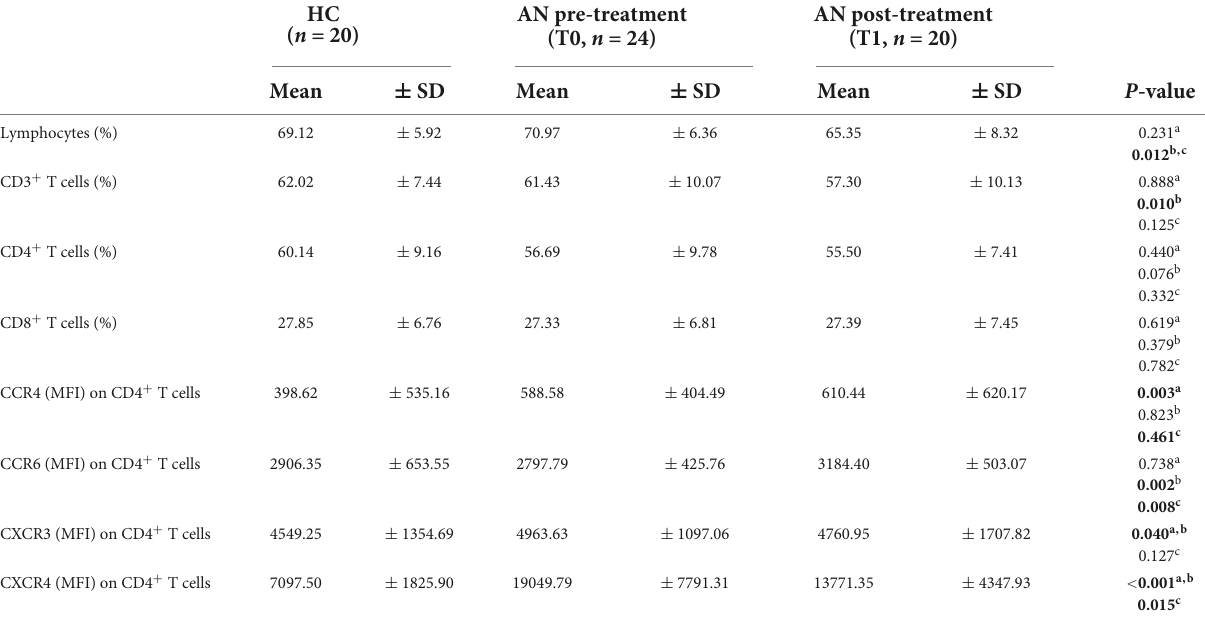
TABLE 3 Comparison of immunological characteristics between HC and AN at T0 and